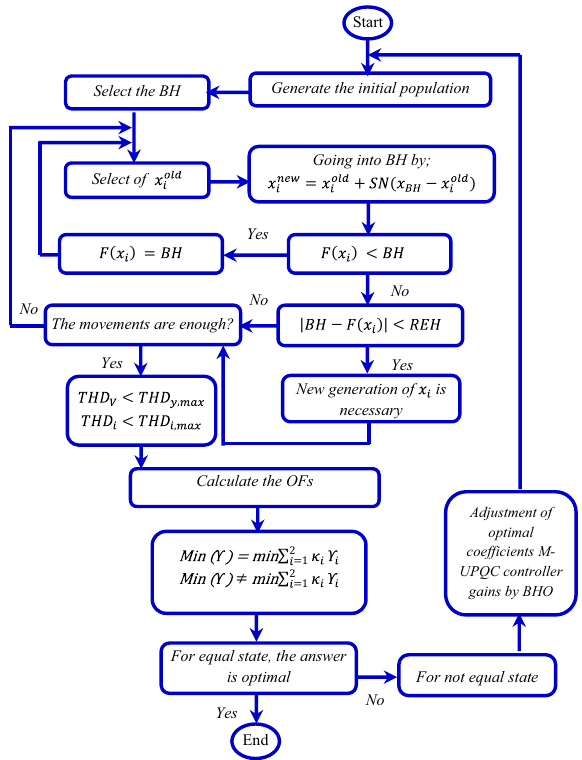
Figure 7. Flowchart of the proposed technique based on BHO method.